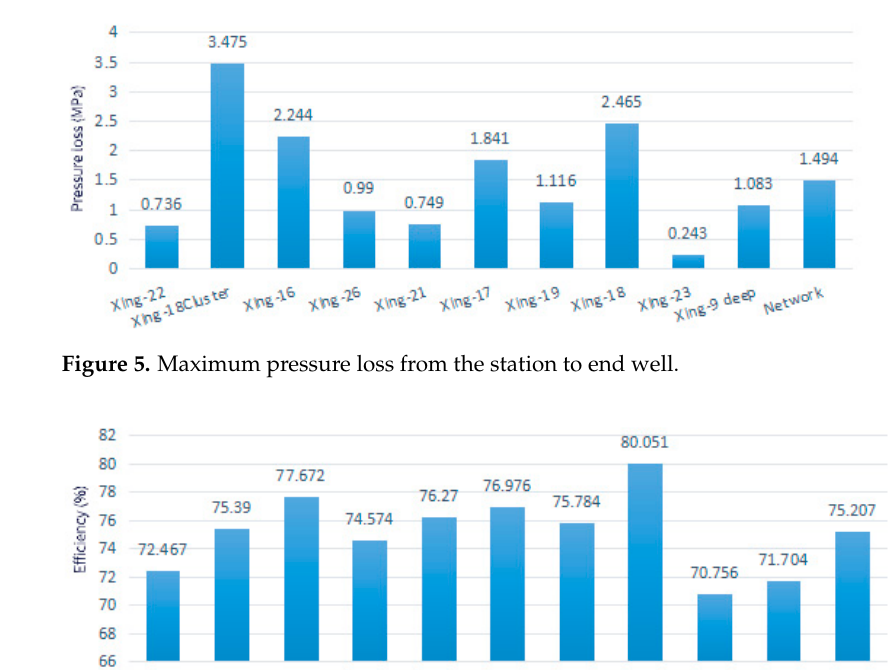
Figure 4. The waterflooding radius of the system.